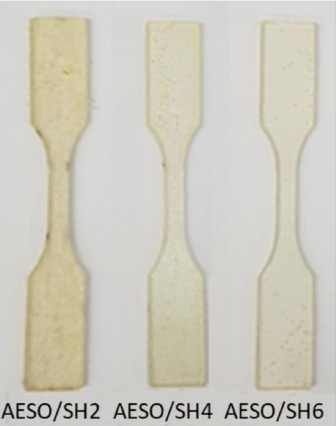
Figure 6. Images of the dog-bone shaped samples die cut from polymer samples.